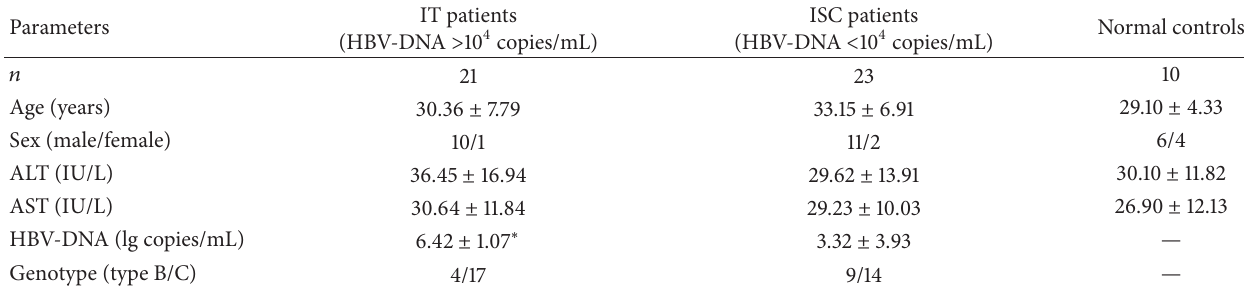
Table 1: Clinical characteristics of patients and normal controls (mean ±